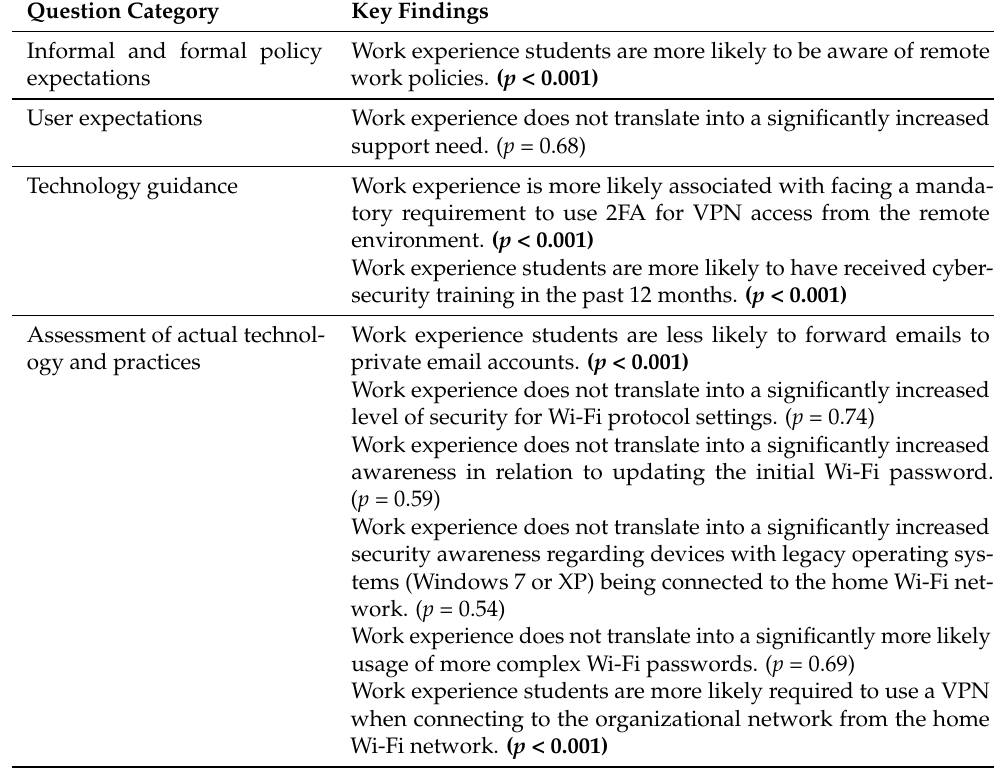
Table 3. Summary of key findings: Remote work (study) security and Wi-Fi